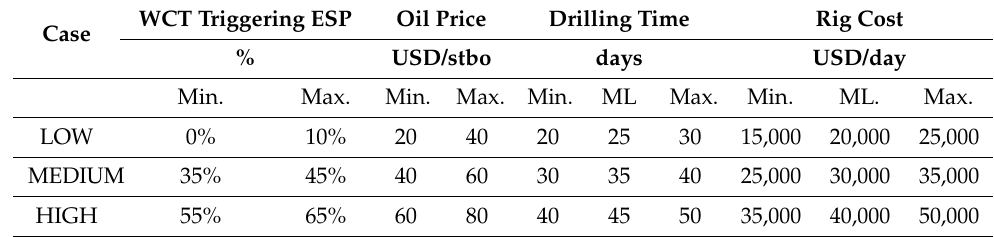
Table 5. Main parameters influencing profitability, with their subintervals.